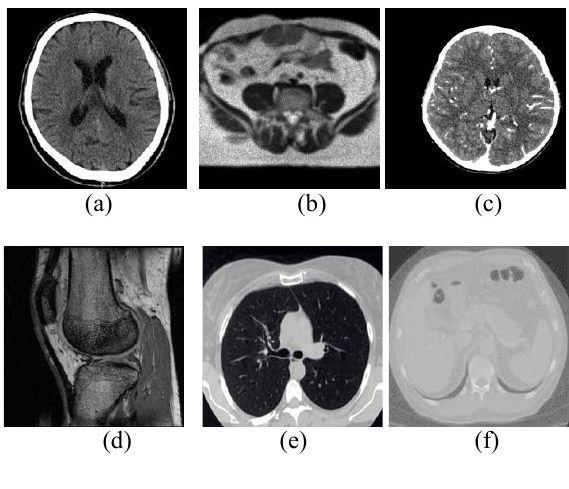
Figure 2 . Sample images from dataset